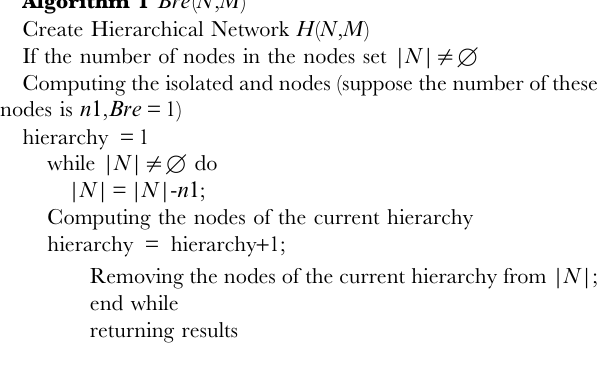
Algorithm 1 Bre ( N , M )